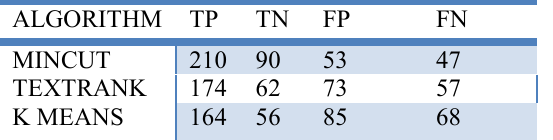
Table 1. says that Min-cut Algorithm gives the best value for the confusion matrix .